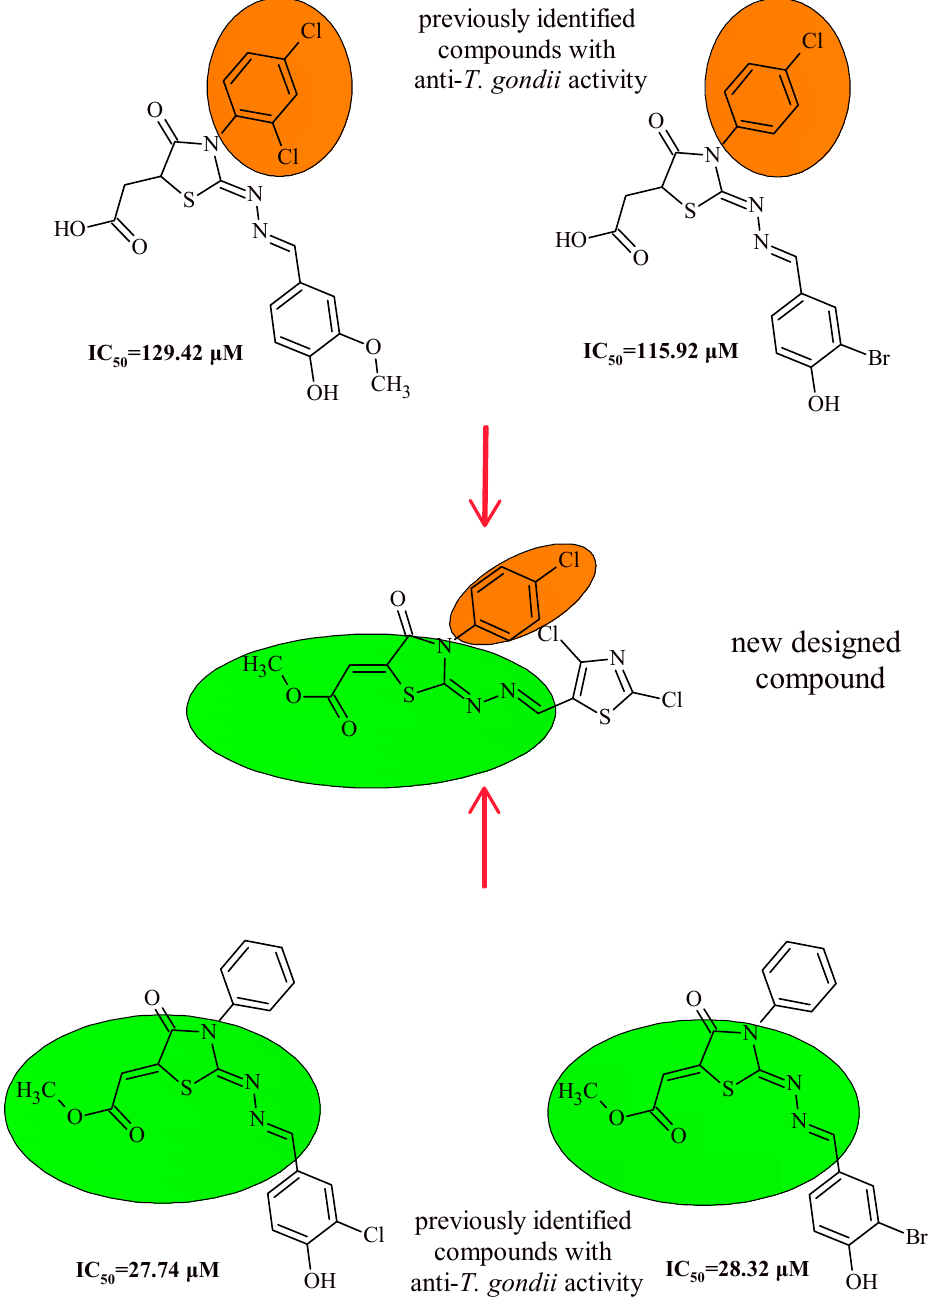
Figure 1. (4-Oxothiazolidin-5-yl/ylidene)acetic acid derivatives with anti- T. gondii activity and new designed compound.